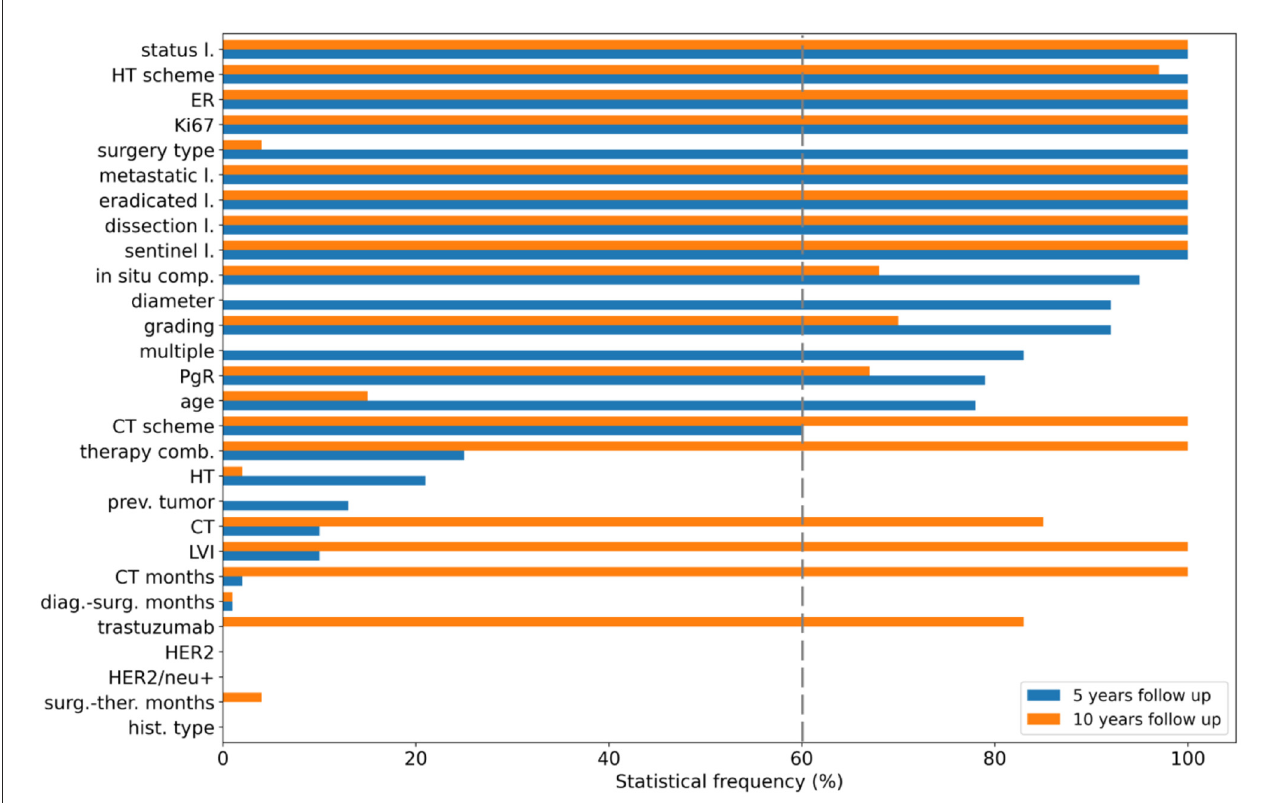
FIGURE3 Feature selection. Statistical frequency of the features selected in nested cross-validation for the 5-year follow-up (blue bars) and the 10-year follow-up (orange bars). Features are ranked according to their importance with respect to the 5-year predictive model.